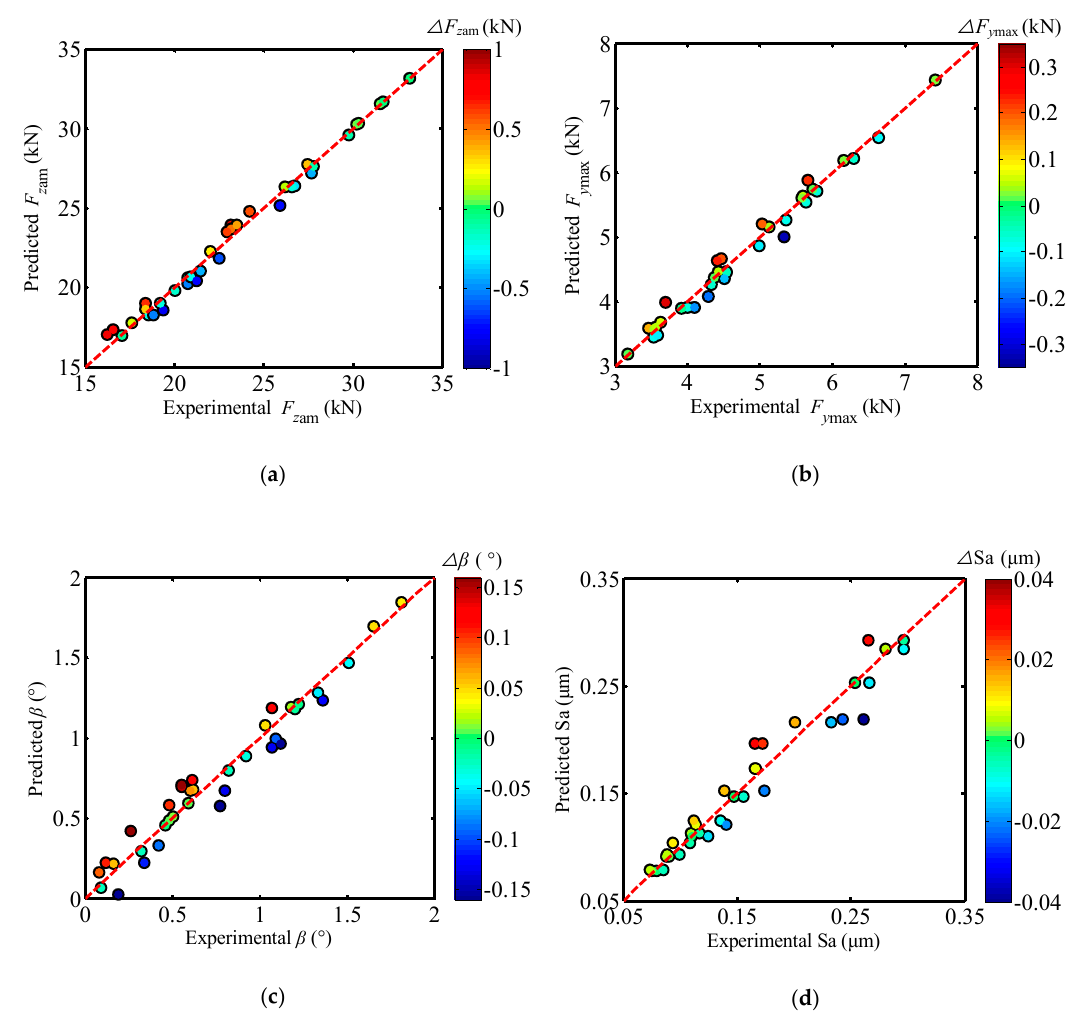
Figure 10. Correlation of predicted values versus experimental values: ( a ) F z am ; ( b ) F y max ; ( c ) β ; and ( d ) Sa.